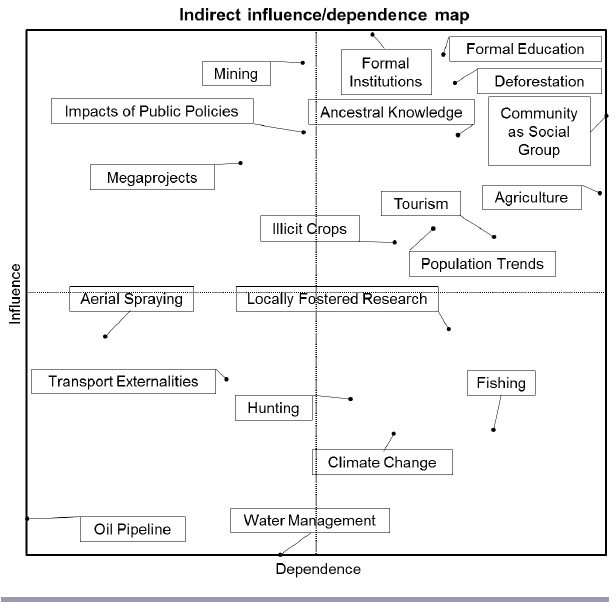
Fig. 10 . Influence/dependence map for indirect influences in